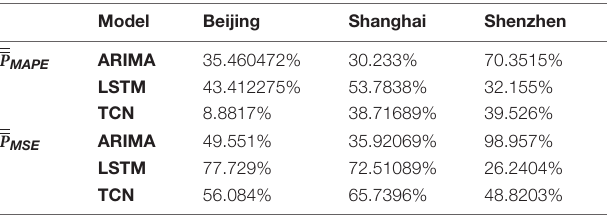
TABLE 11 | Improvement ratio (IR) for CO of different models ( × 100%).